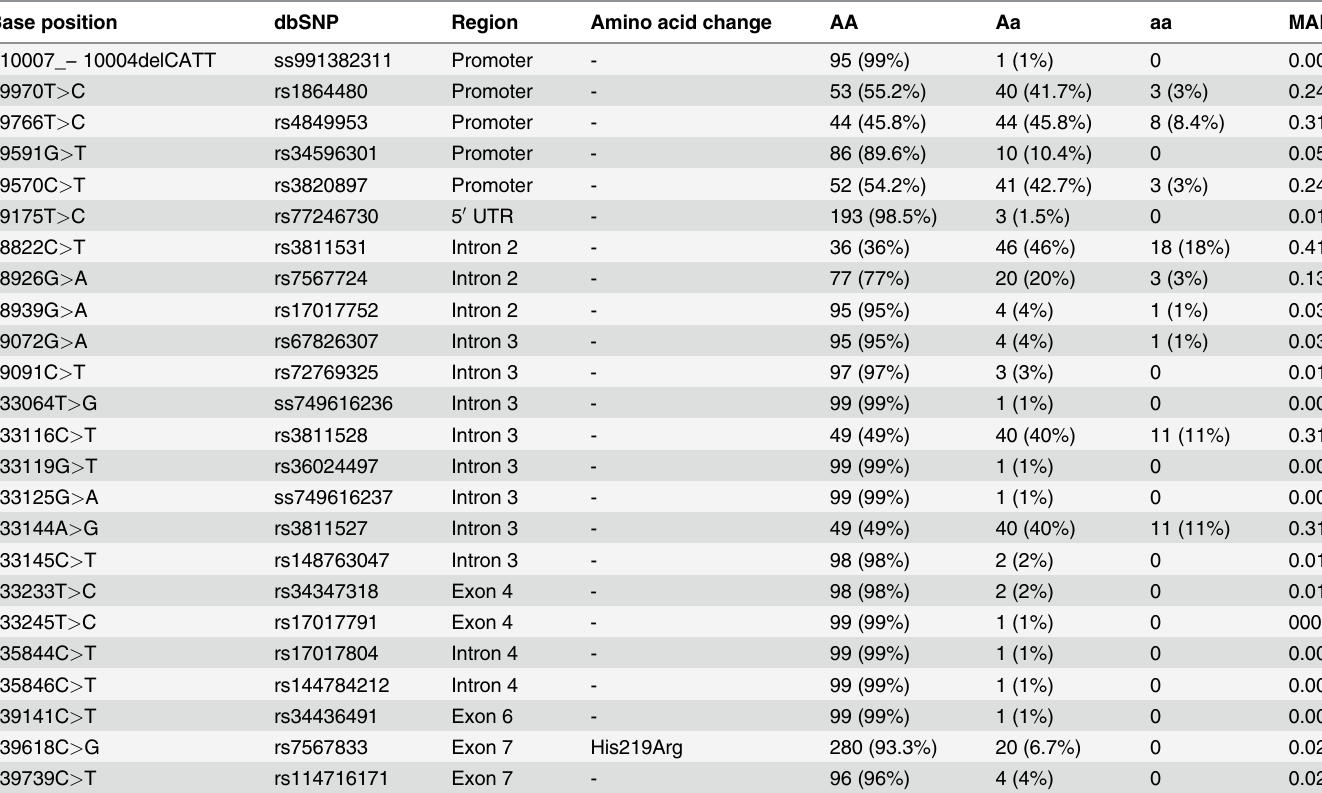
Table 3. Genetic variation observed in the COLEC11 gene.